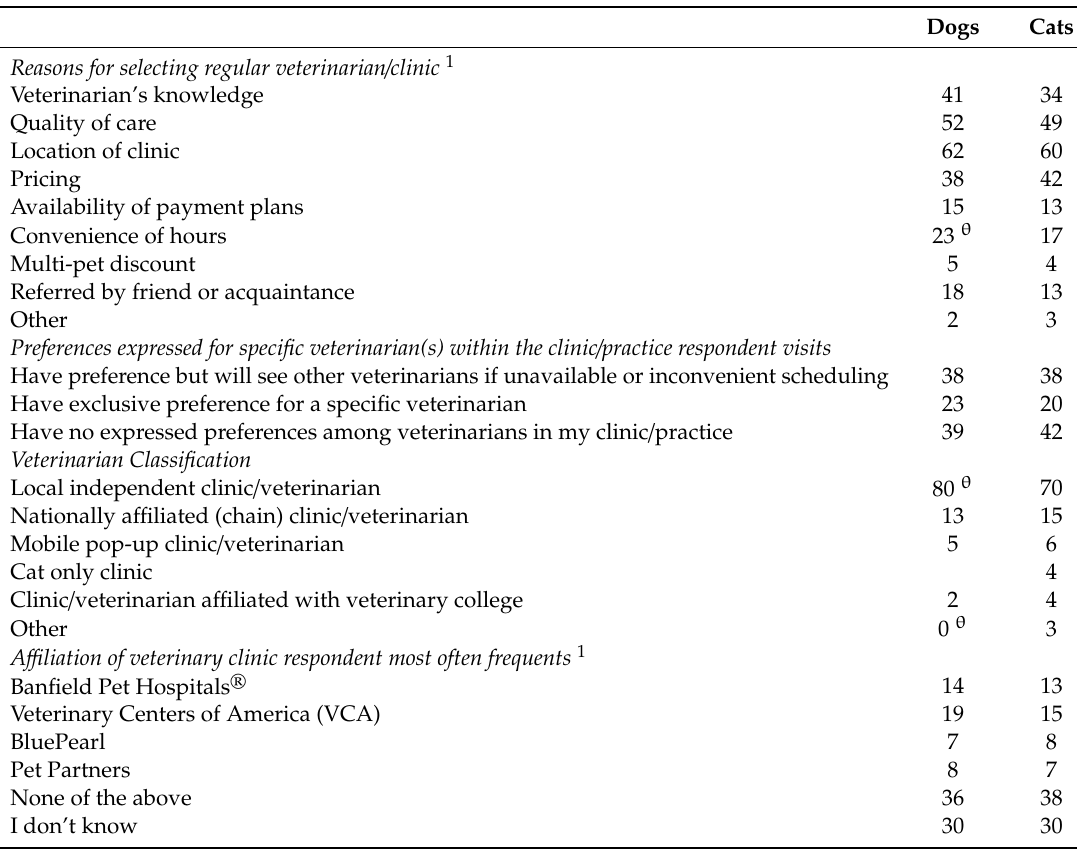
Table 6. Views and use of veterinary services, and statistical comparison between dog and cat